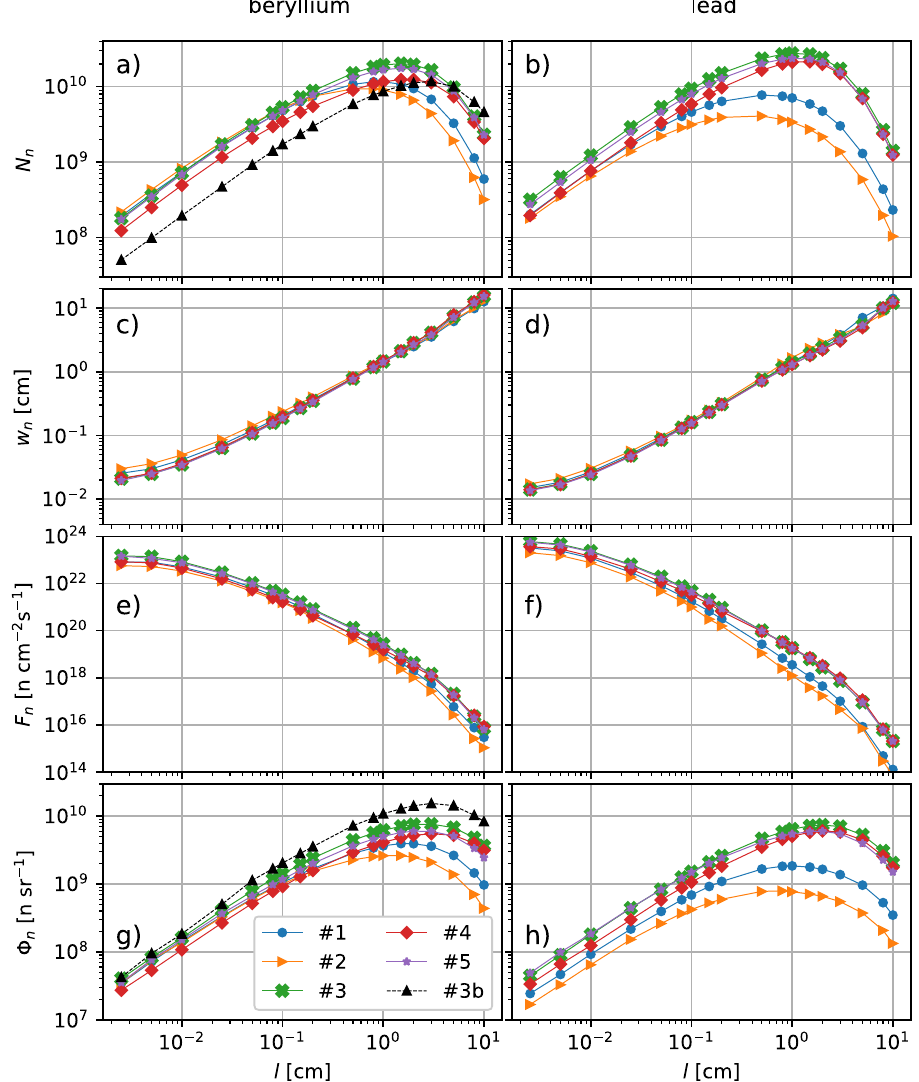
Figure 6. Properties of the neutron source as a function of the converter length. ( a , b ) Total yield, ( c , d ) transverse beam size, ( e , f ) peak instantaneous flux and ( g , h ) on-axis yield per unit solid angle. The first three quantities are measured at the backside of the converter while the latter is recorded on axis, 20 cm behind the converter. The left and right columns correspond to the Be and Pb converters, respectively. The labels of the different curves are as listed in Table